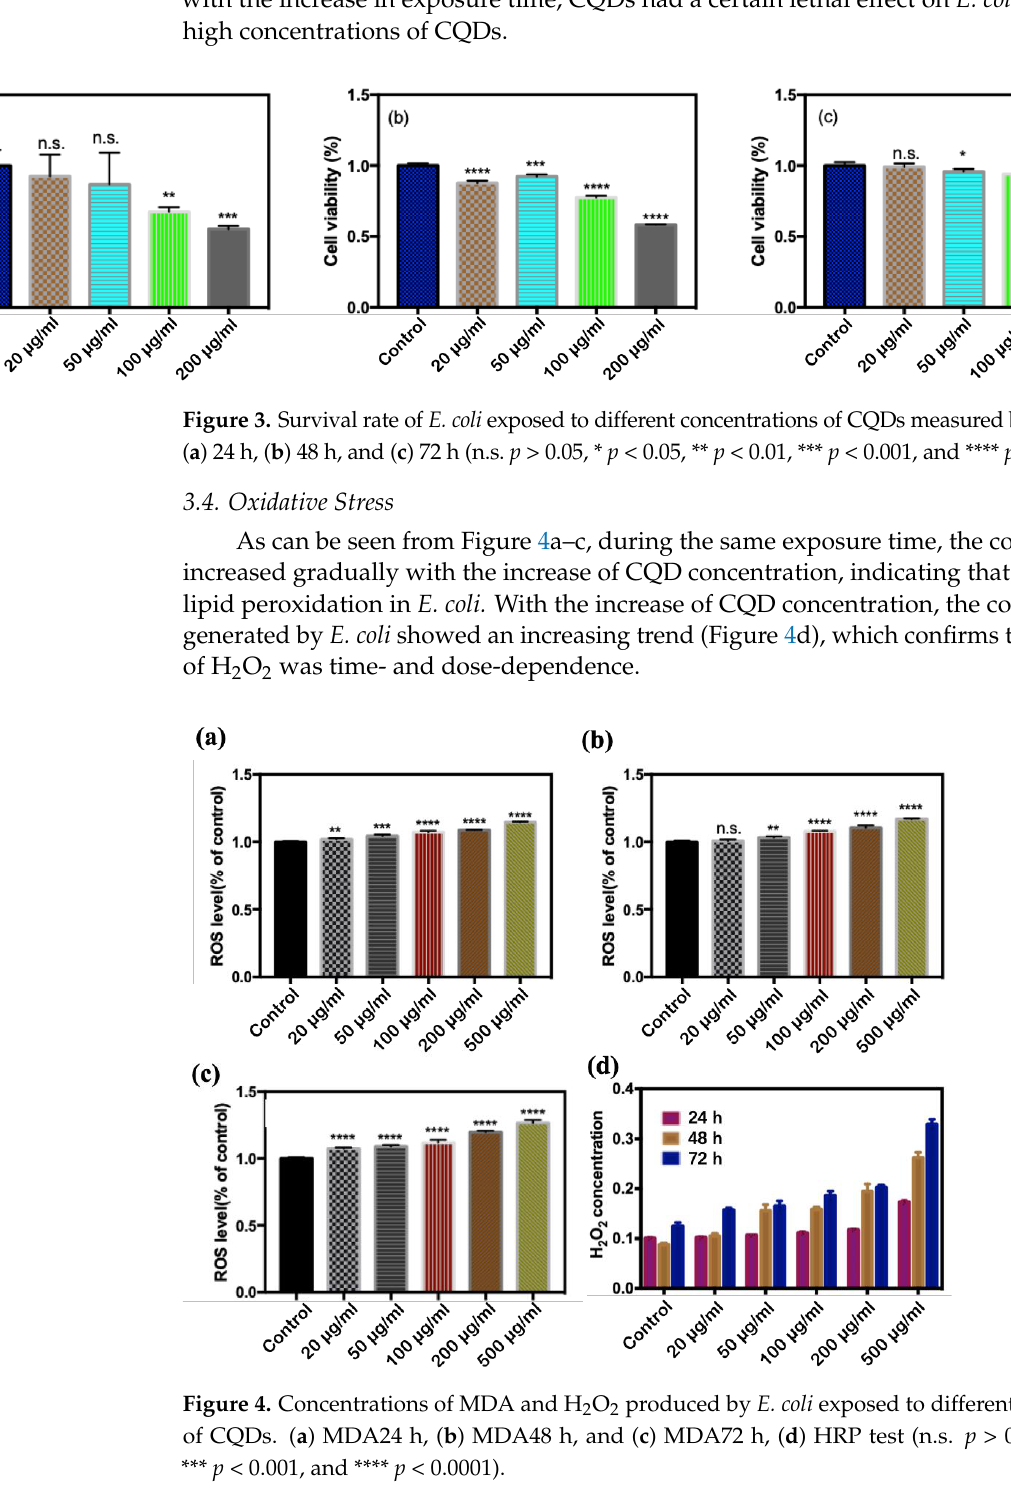
Figure 2. ( a ) Growth curve of E. coli in different concentrations of CQDs; ( b , c ) bacteriostatic test results and CFU count of exposure to different concentrations of CQDs (n.s. p > 0.05).